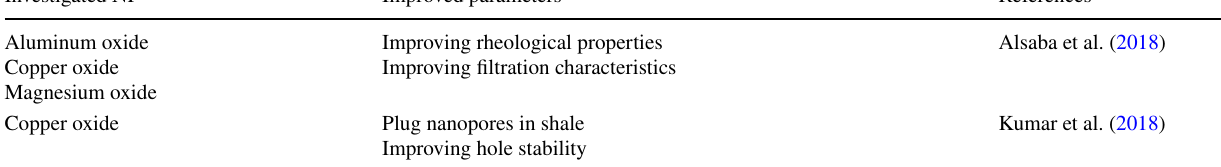
Table 2 Application of nanoparticles for drilling fluids Investigated NP Improved